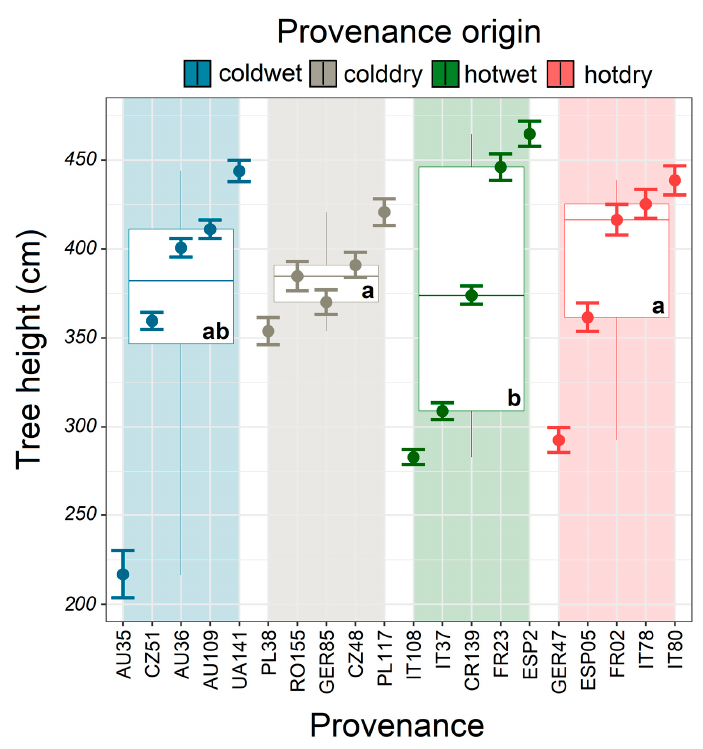
Figure 6. Mean and 95% confidence intervals of simulated height growth (2040–2060), for 20 prov- enances, from 4 provenance groups with contrasting original climate. Boxplots on provenance group level with lowercase letters showing results of Tukey HSD post-hoc test. AU—Austria, CR— Croatia, CZ—Czech Republic, ESP—Spain, FR—France, GER—Germany, IT—Italy, PL—Poland, RO—Romania,